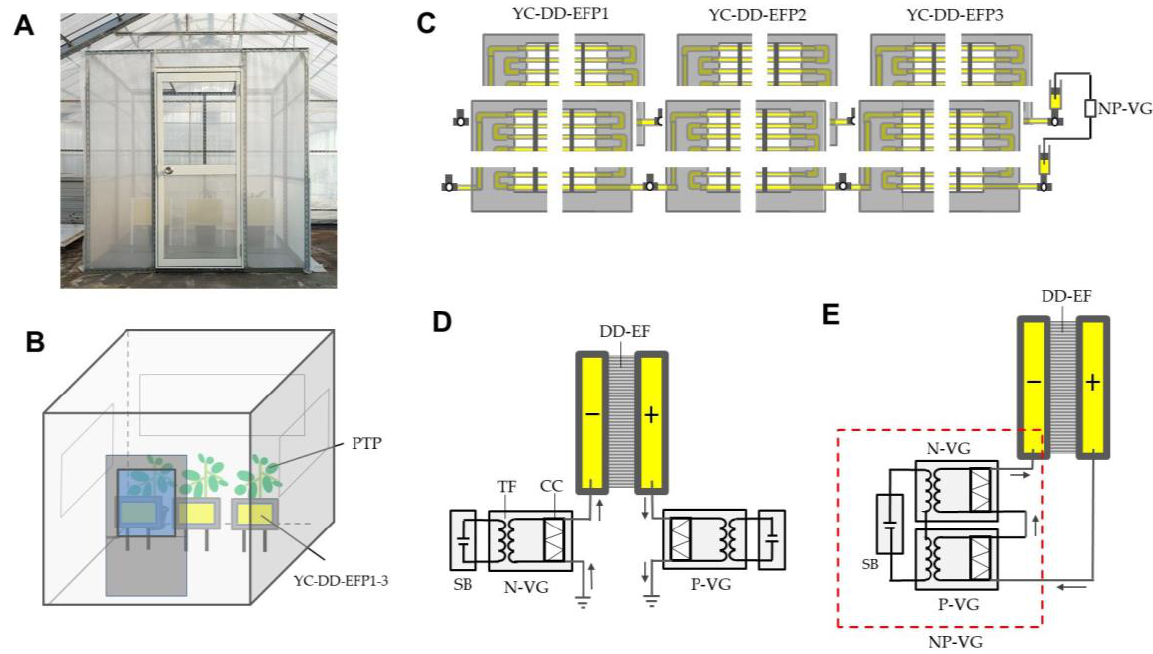
Figure 4. ( A ) Polyvinyl chloride-sheeted film house (2 m 3 ) placed in a greenhouse, where an insect attraction assay was conducted. ( B ) Three potted tomato plants (2 months old, 1 m high) and triplicated yellow-colored double-charged dipolar electric field producers (YC-DD-EFPs) placed in front of plants in the film house. ( C ) Triplicated YC-DD-EFP1 3 placed in front of the plants. ( D , E ) Schematic representations of grounded ( D ) and non-grounded ( E ) circuits integrated into the voltage generator. Arrow indicates the direction of movement of negative electricity or free electrons. Abbreviations: PTP, potted tomato plants; YC-DD-EFP1 3, triplicated YC-DD-EFPs; DD-EF, double-charged dipolar electric field; TF, transformer; CC, Cockcroft circuit; SB, storage battery; P-VG, positive voltage generator; N-VG, negative voltage generator; NP-VG, negative and positive voltage generators unified in a box.